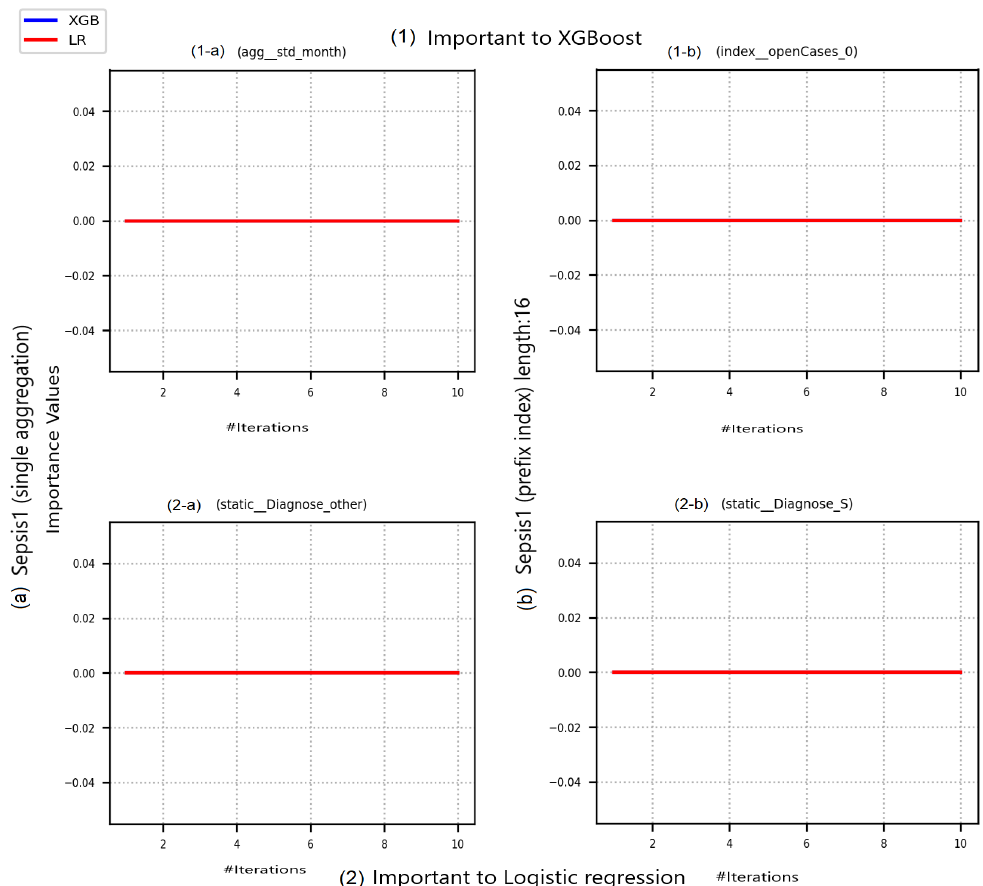
Figure 6. PFI scores over Sepsis1 event